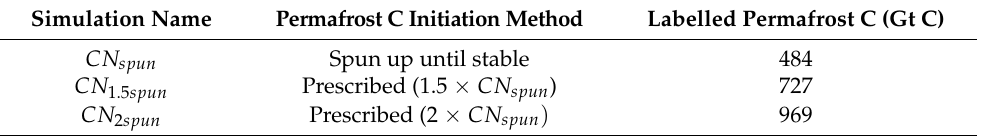
Table 1. JULES-IMOGEN initialisation of the labelled permafrost carbon that is permanently frozen in the soil at the start of the simulation. Uncertainties in the initial labelled permafrost C pool are also represented, via 1.5 × and 2 × the spun up labelled permafrost carbon (second and third rows). Here the initial and labelled permafrost C pool excludes any carbon that is above the top of the permafrost